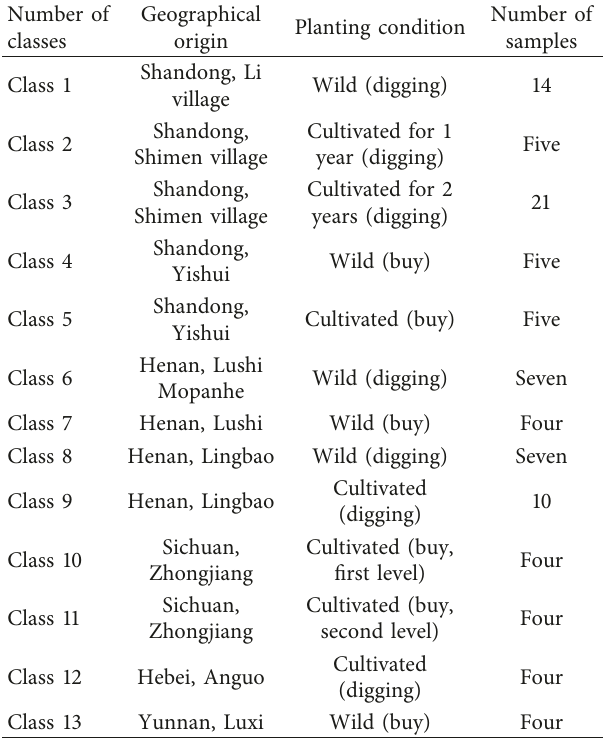
Table 1: Geographical origins and planting conditions of the Salvia miltiorrhiza